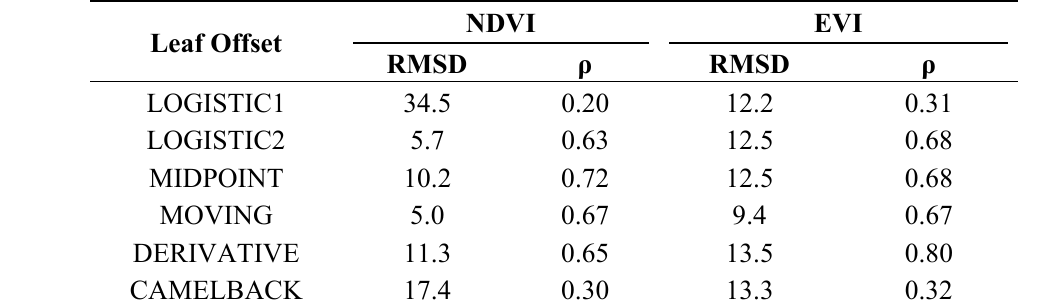
Table 5. Performance of modeled